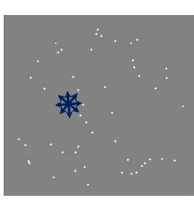
Fig. 3. Visual stimulus screen shot. Blue arrows denote the imaginary expansion center of the moving white dots on the gray screen.